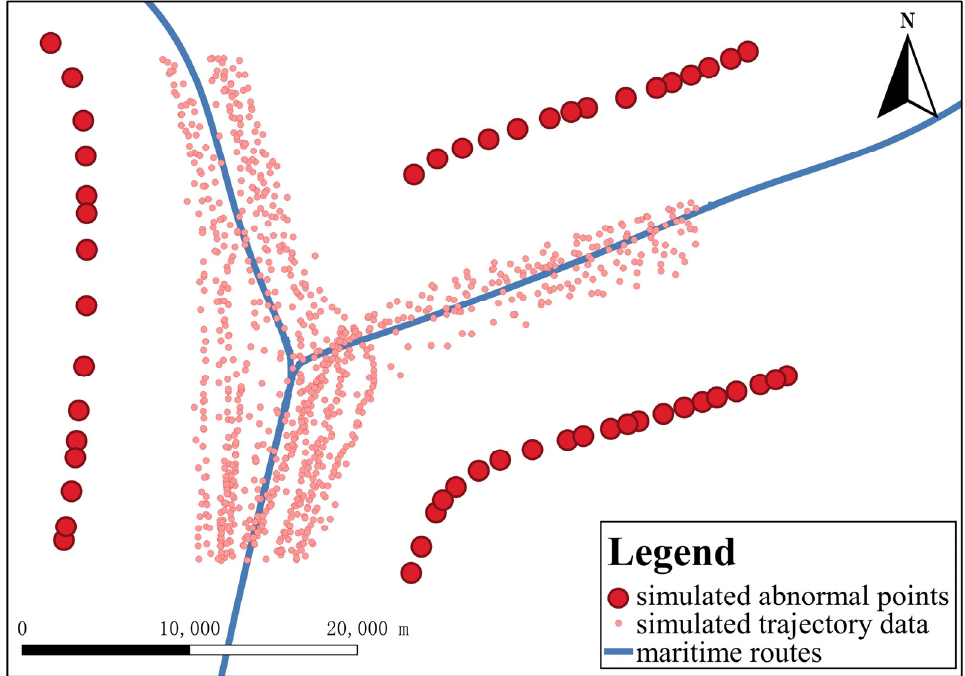
Figure 7. Simulation data for abnormal behavior of ship spatial attributes.